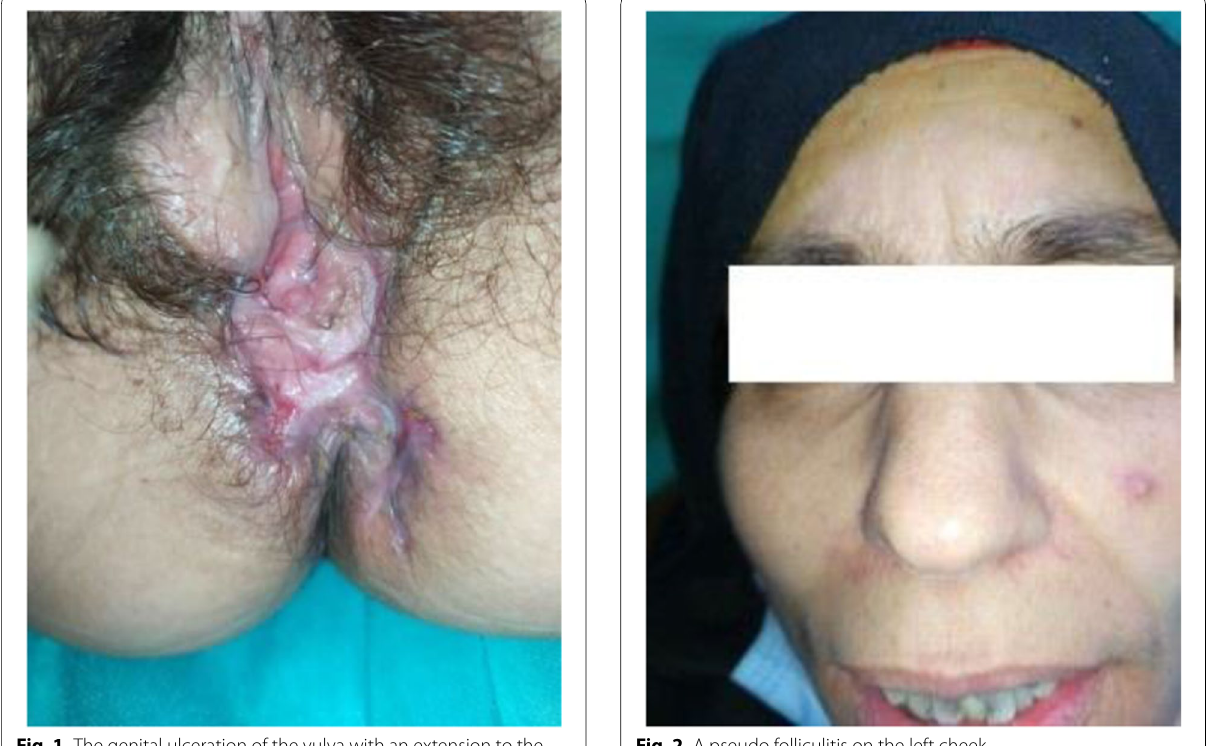
Fig. 1 The genital ulceration of the vulva with an extension to the perianal region before treatment